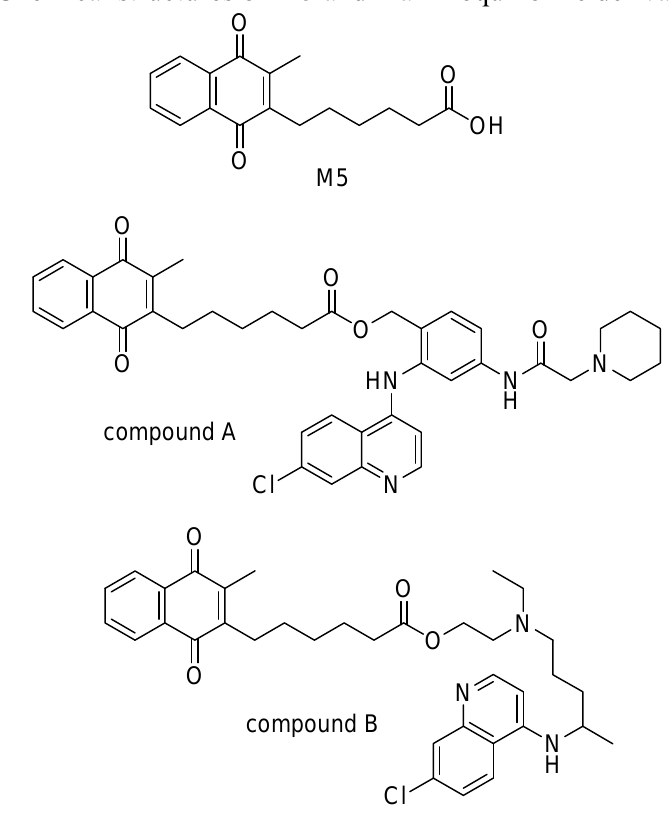
Figure 19. Chemical structures of M5 and 4-aminoquinoline derivative